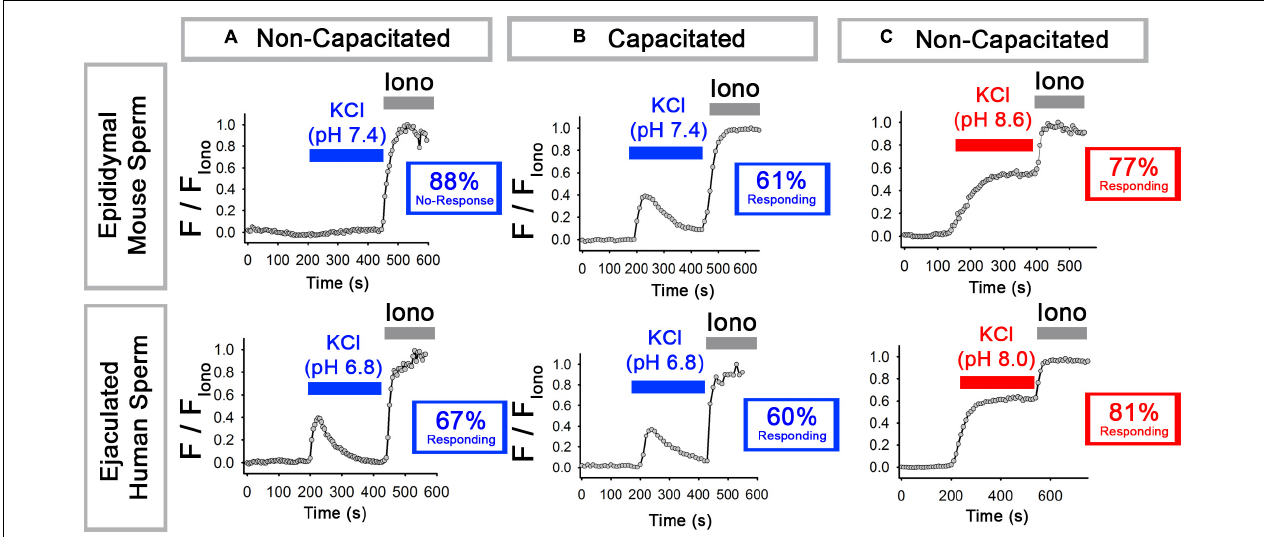
FIGURE 1 | Epididymal mouse sperm and ejaculated human sperm show different [Ca 2 + ] i responses to KCl. (A,B) Representative traces of the most prevalent [Ca 2 + ] i responses to 50 mM KCl at (top) pH 7.4 in epididymal mouse sperm and (bottom) at pH 6.8 in ejaculated human sperm in (A) non-capacitating and (B) capacitating conditions. (C) Representative traces of the most prevalent [Ca 2 + ] i responses to 50 mM KCl at (top) pH 8.6 in epididymal mouse sperm and (bottom) at pH 8.0 ejaculated human sperm in non-capacitating conditions. Numbers in boxes indicate the percentage of sperm that did or did not respond (see Results and Methods for how “responding” was defined).